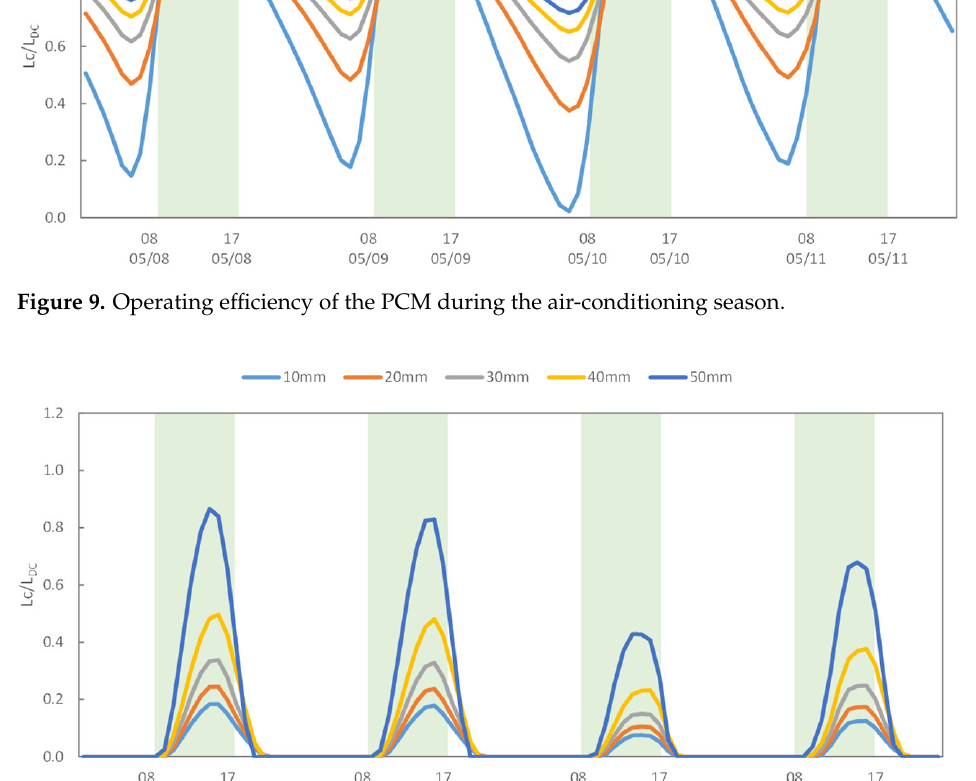
Table 5. Comparison of annual efficacy of a PCT of 25 °C or 29 °C in Taipei.